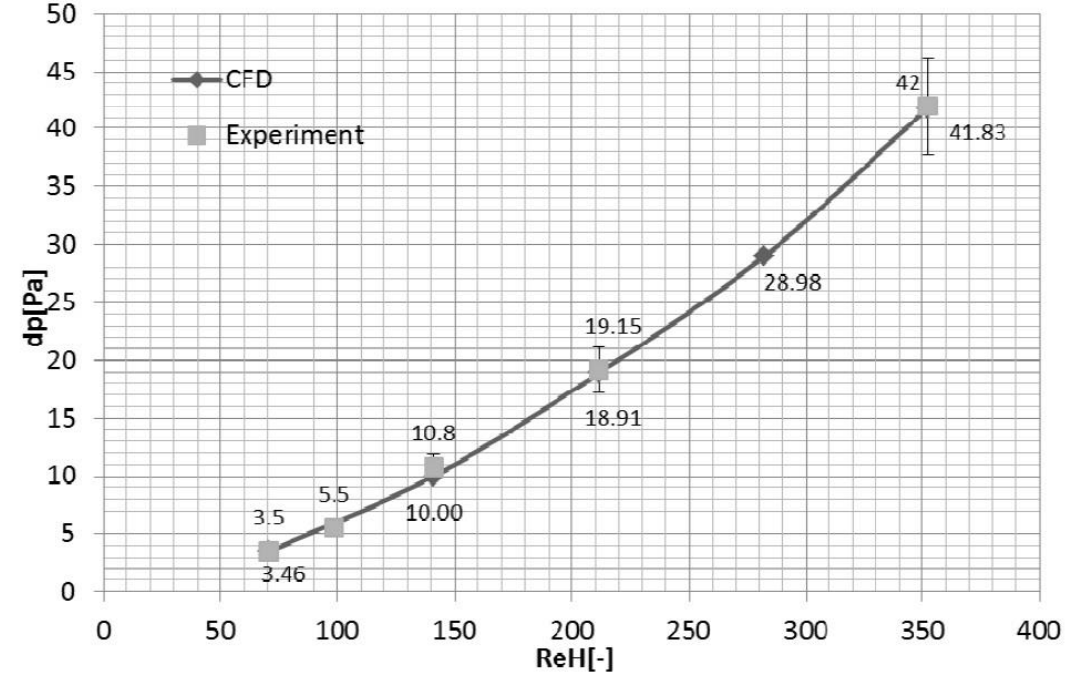
Figure 8: Comparison of numerically & experimentally achieved average pressure drop for the louvered fin